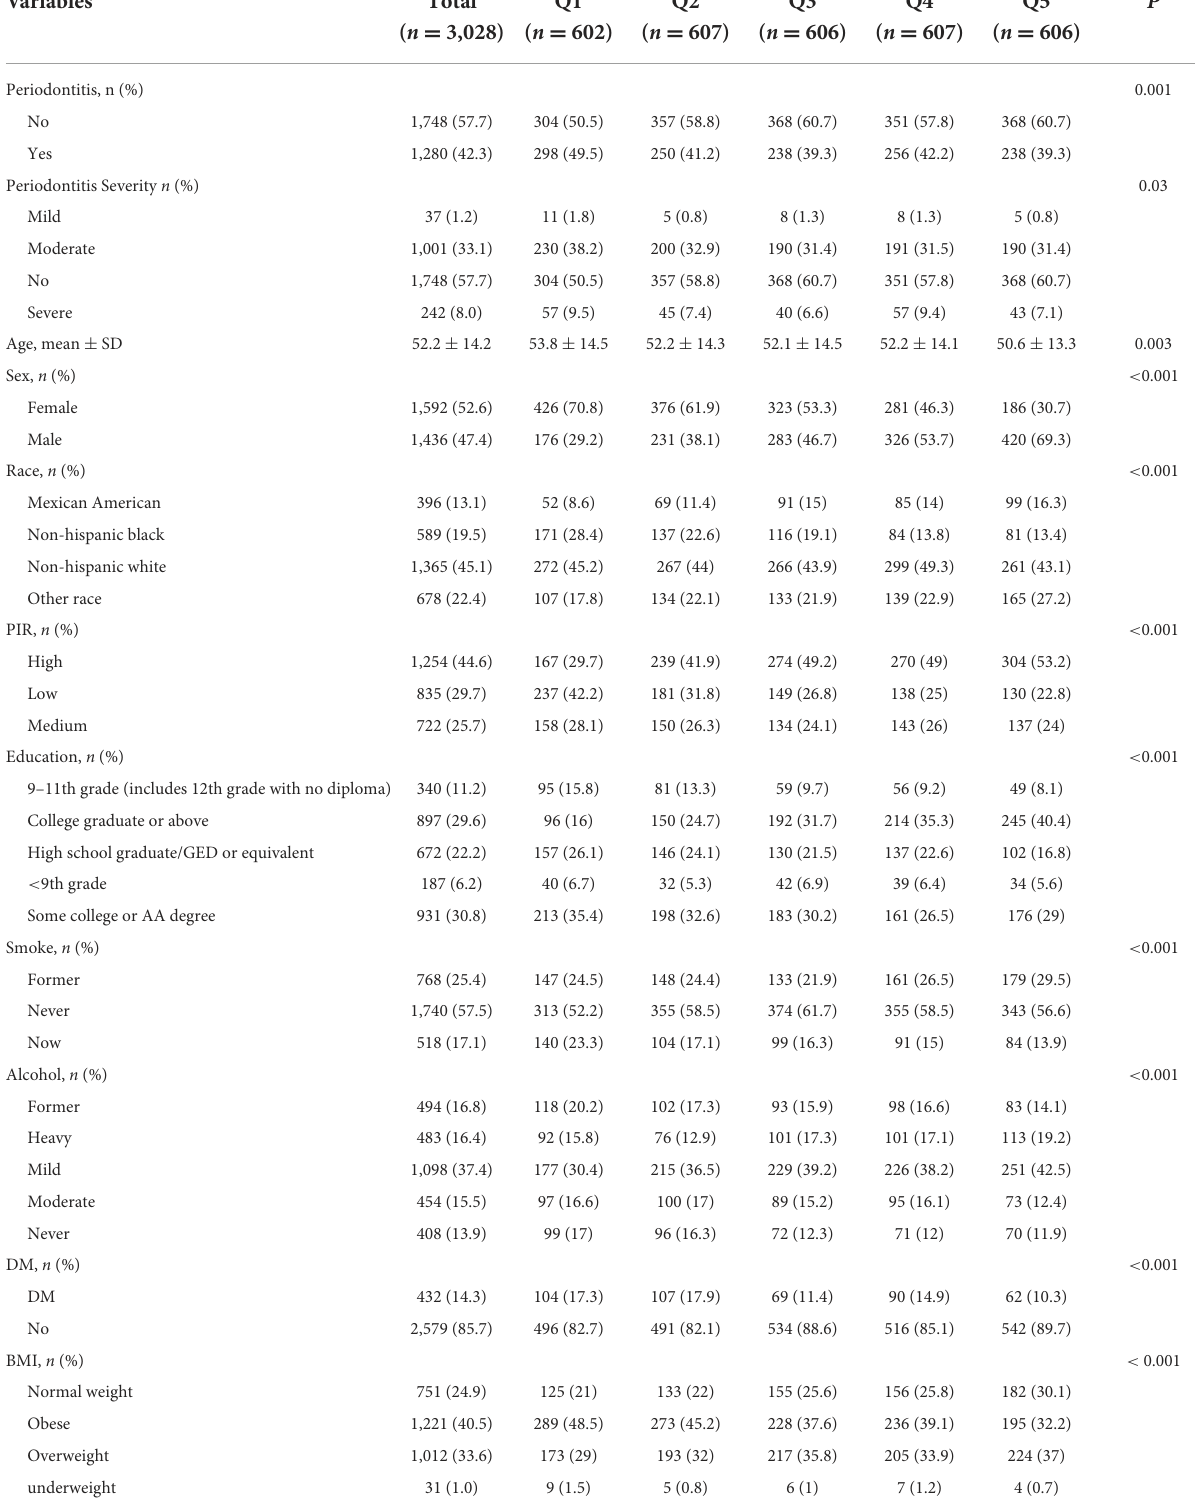
TABLE 1 Characteristics of the overall target population according to dietary magnesium